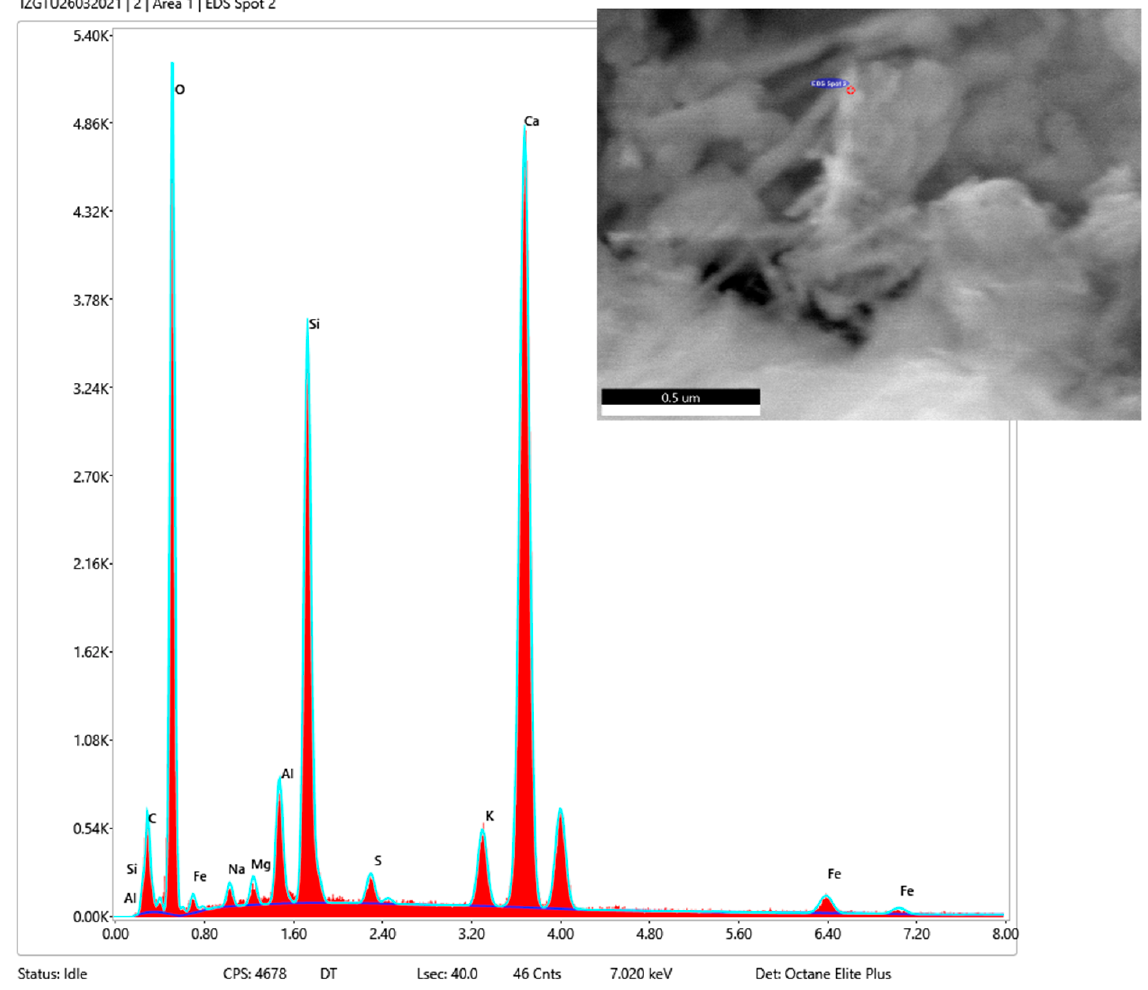
Figure 8. X-ray microanalysis of crystalline hydrates on the surface of chrysotile fibers.